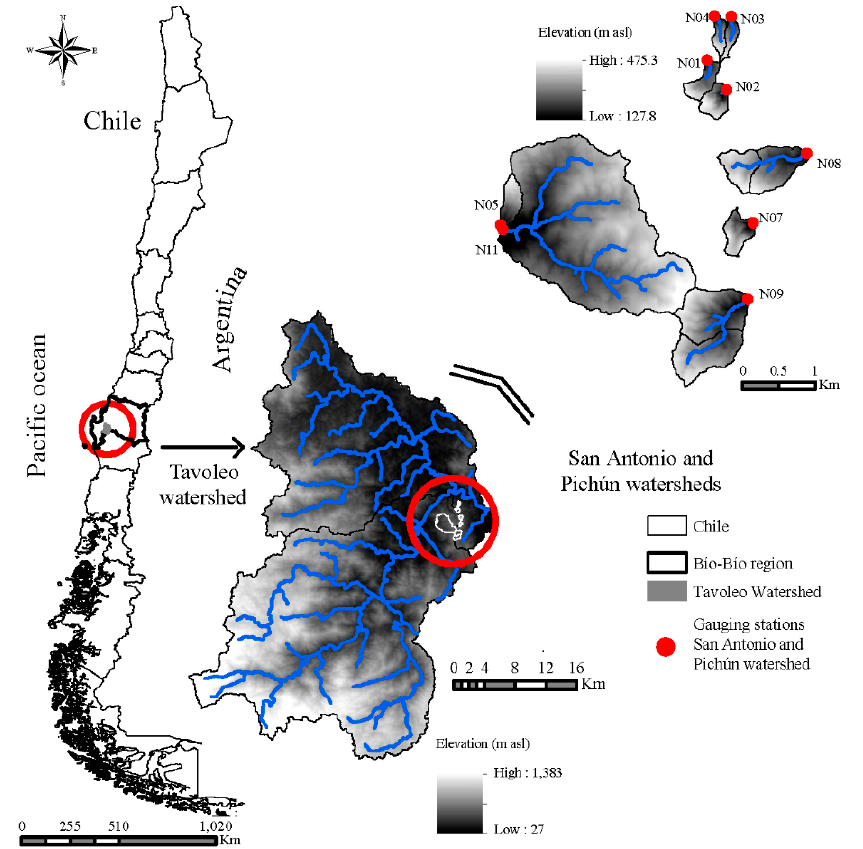
Figure 1. Sampling since 10 November 2015, and 18 August 2016 of benthic algae communities in nine study watersheds, located in San Antonio and Pichún higher-order watersheds, Chilean Coastal Range, Biobío region.